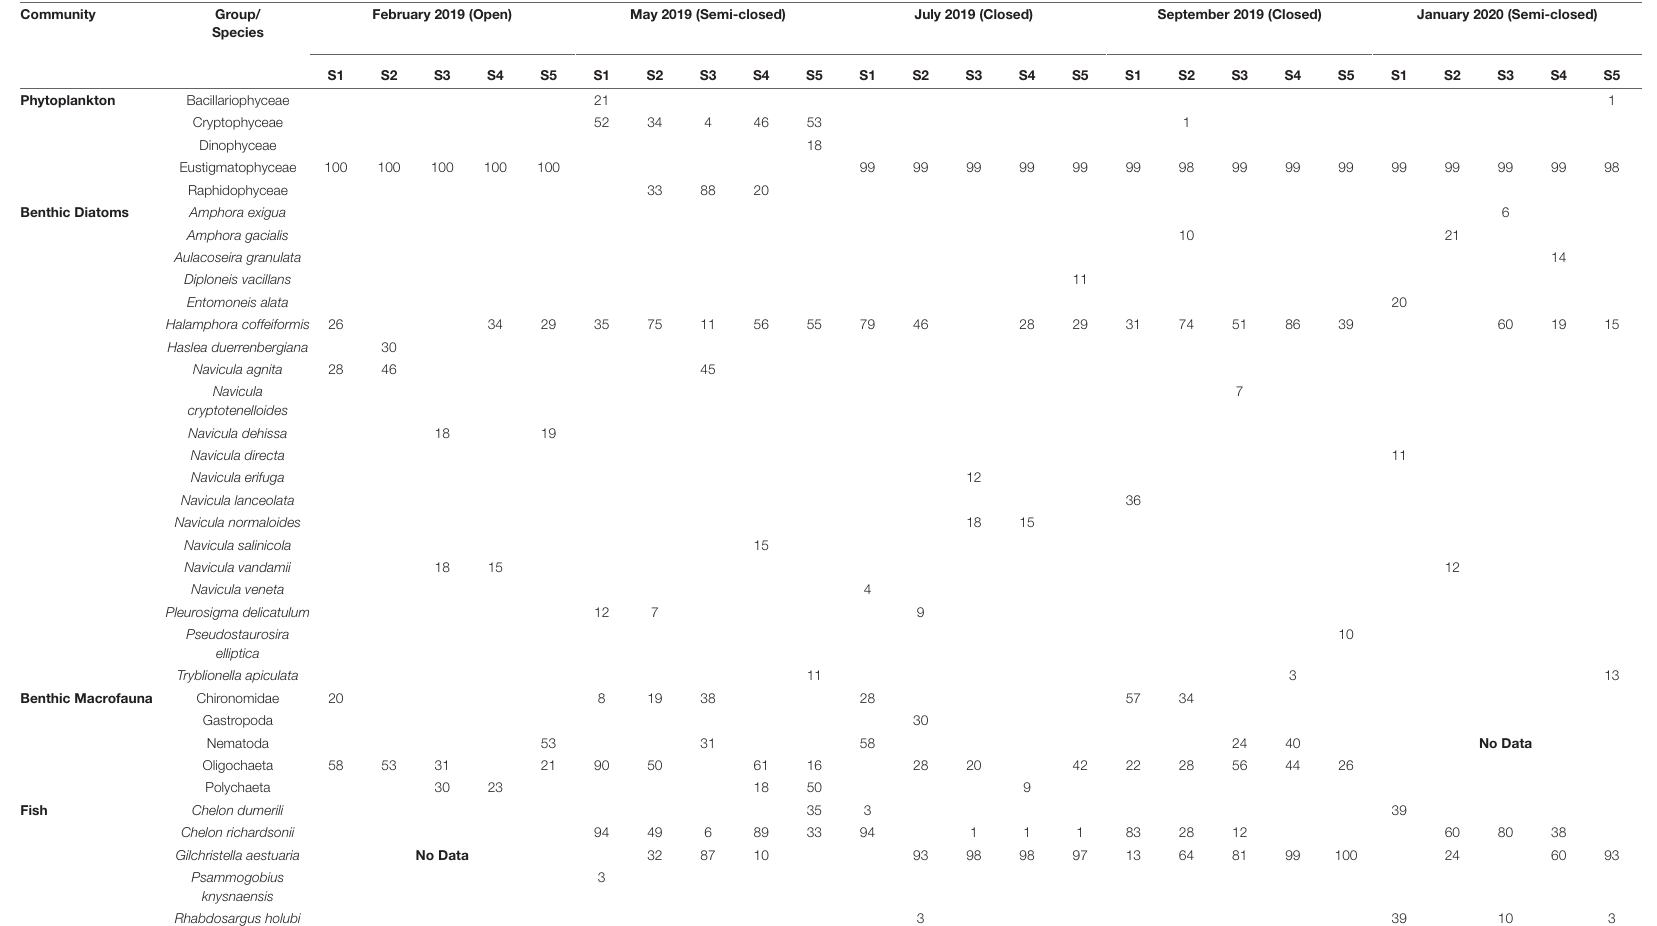
TABLE 1 | Relative abundance (%; RA) of the dominant groups/species (min. ≥ 1%) observed for each biotic community along the length of the Hartenbos Estuary.